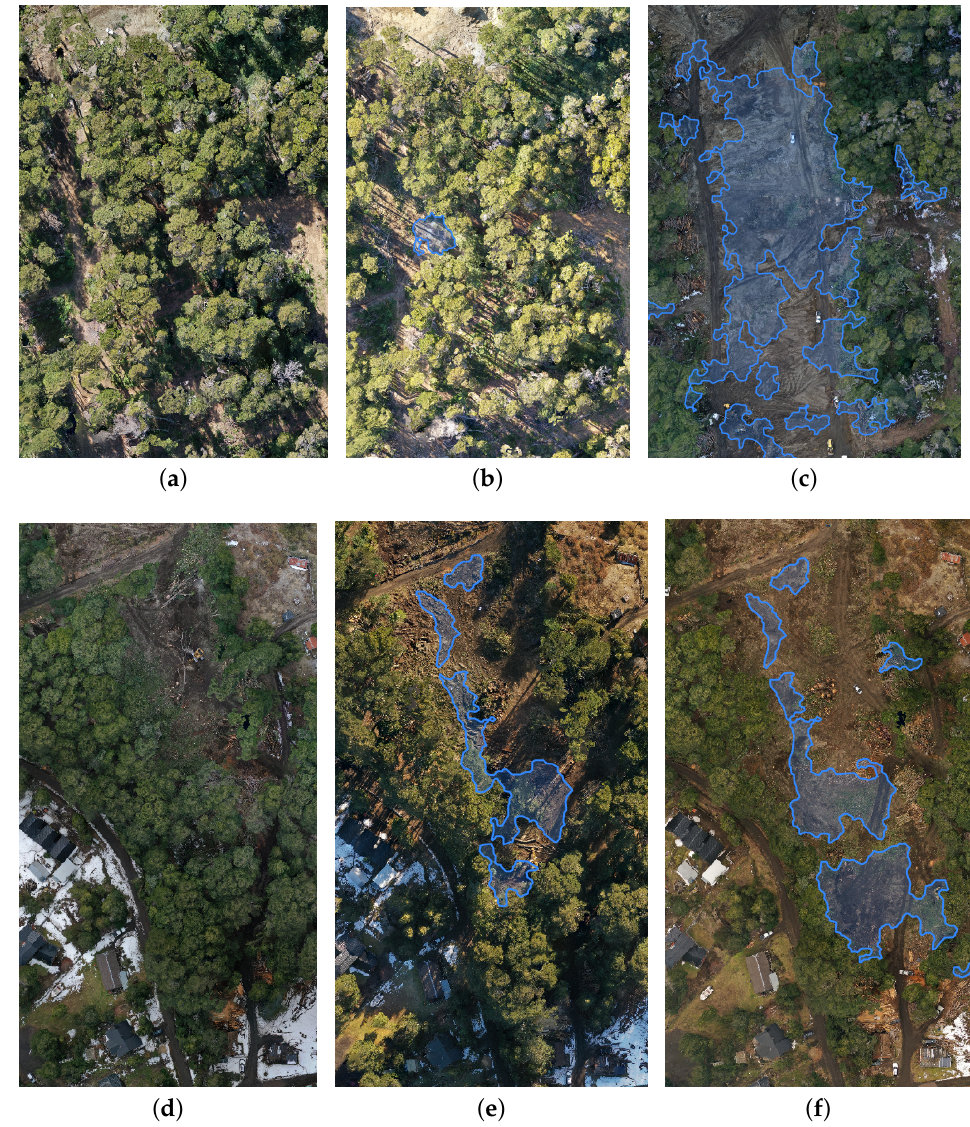
Figure 21. Orthomosaics obtained from two flights (first flight, top row, second flight, bottom row). Leftmost image is the reference orthomosaic and the middle and the rightmost ones are from the two following flights over the same areas, after different trees were cut down. Areas detected by our detection system are highlighted in blue. ( a ) First survey. ( b ) Second survey. ( c ) Third survey. ( d ) First survey. ( e ) Second survey. ( f ) Third